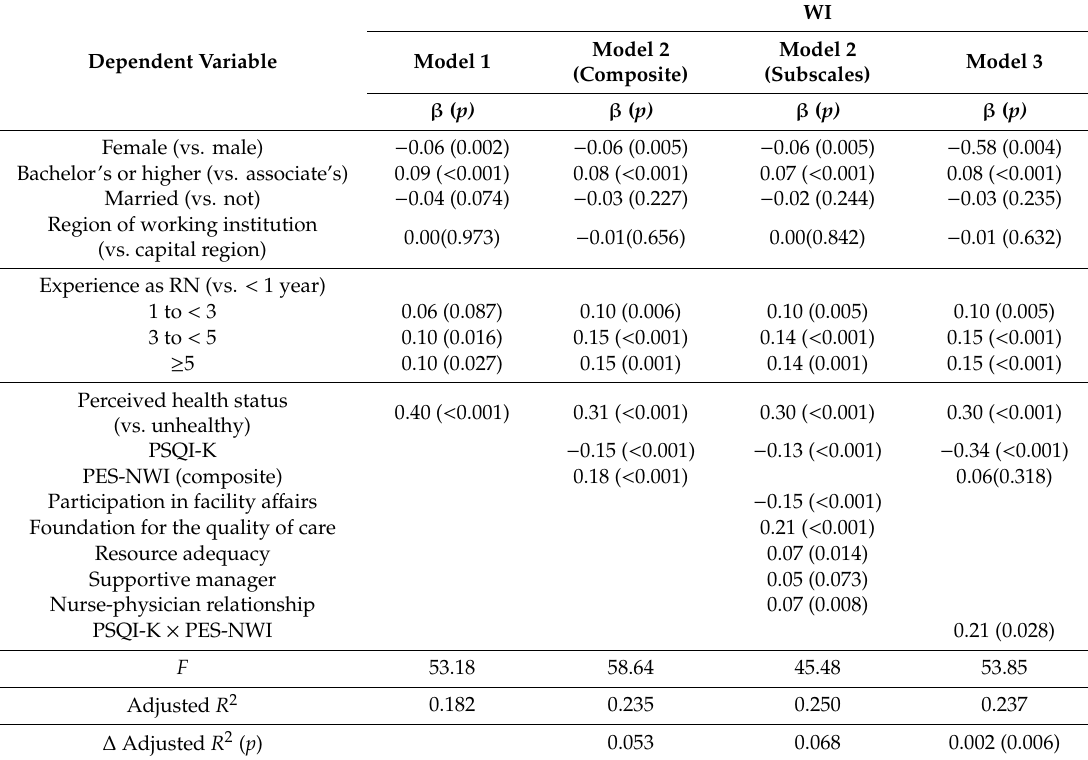
Model 1: Only included the general characteristics of the participants as predictors of wellness. Model 2: Sleep quality and nursing practice environment components were added. Model 3: The interaction term between sleep quality and nursing practice environment was